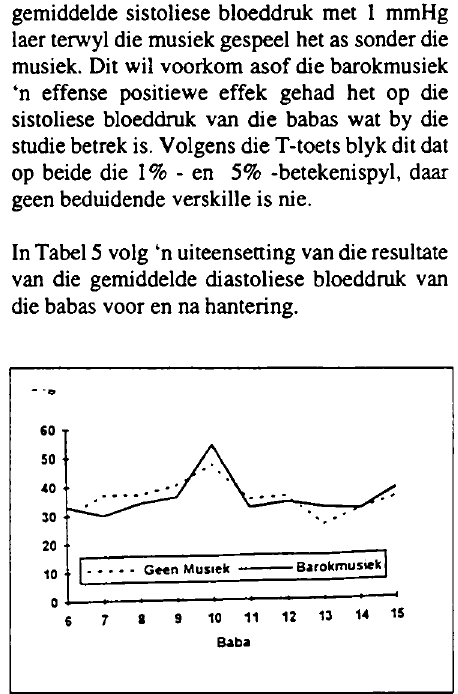
FIguur 9: Gemiddelde diastoliese bloeddruk van die babas voor hantering